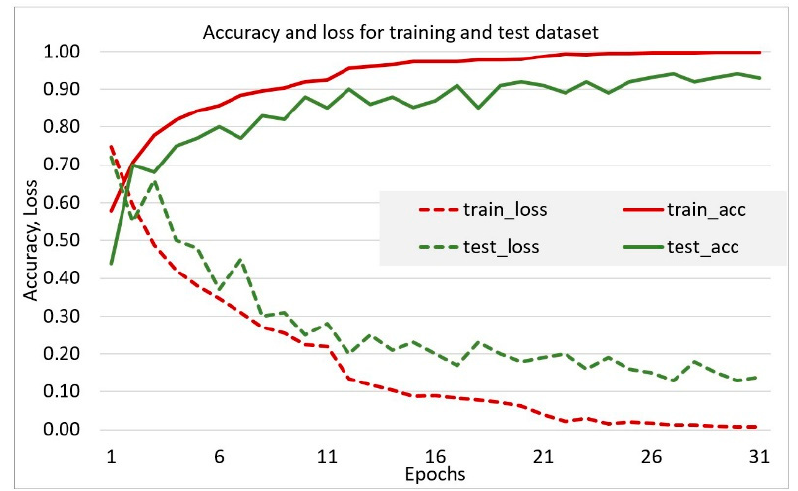
Figure 7. Accuracy and loss for training and test datasets.